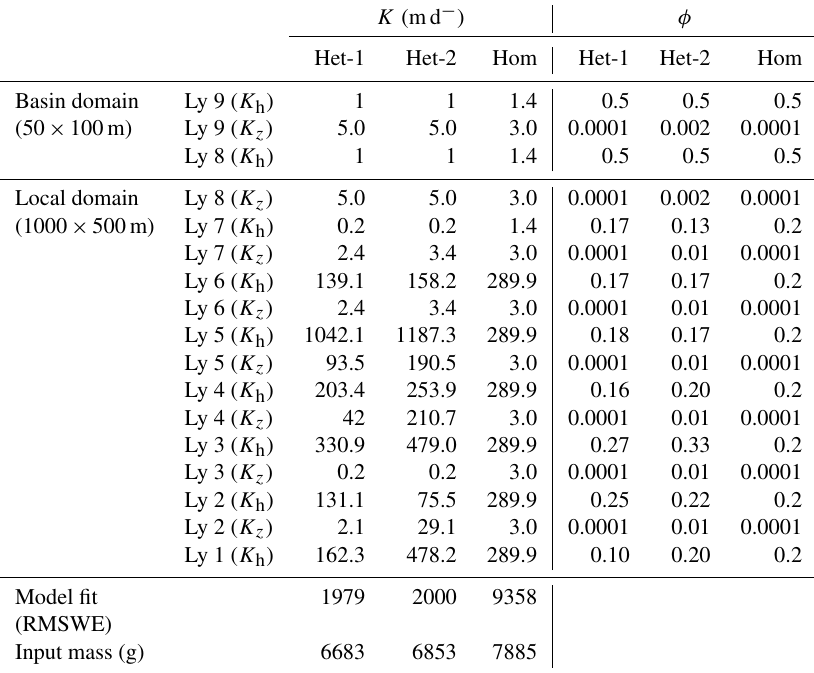
Table 1. Parameters (hydraulic conductivity, K (md − 1 ), and porosity, φ ), RMSWE, and input mass in outcomes Het-1, Het-2, and Hom, after